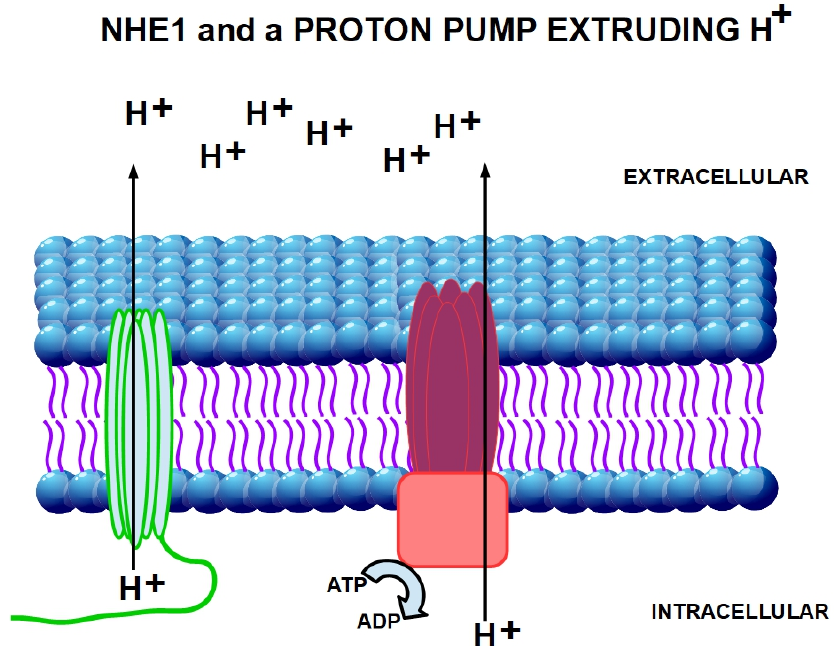
Figure 3. Activity of the proton extruders NHE1 ATPase proton pump. On the left side in green, it is represented the active secretion of cellular protons into the extracellular space by NHE1. On the other side in red, the active extrusion of cellular protons into the extracellular space by V-ATPase proton exporter is shown. Interestingly, both extrude protons against the gradient; however, while proton pumps need energy (ATP) for their activity, NHE1 does not need ATP to achieve the same purpose.